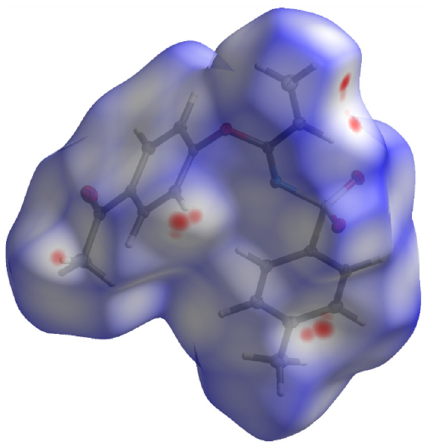
Figure 4. C-H···O, C-H··· π and π - π stacking interactions found in imidate 3 . O···H (29.1%) contacts, confirming previous observations. Figure 4. C-H ··· O, C-H ··· π and π - π stacking interactions found in imidate 3 .